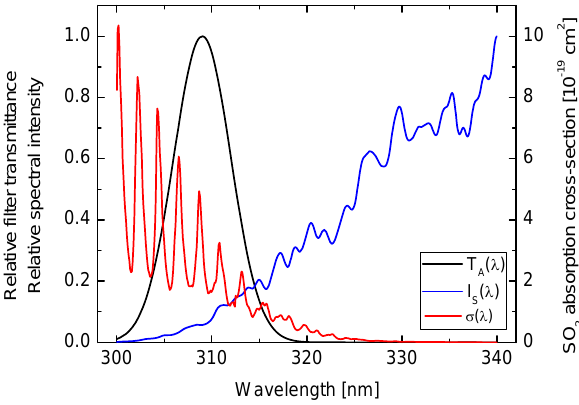
Fig. 1. Example of the spectral transmittance T ( λ ) of a band-pass filter which could be used in a SO 2 camera setup. In this case, the maximum transmittance is centered at 309nm, a region in which the SO 2 absorption-cross-section σ ( λ ) is prominent (Bogumil et al., 2003). Also shown in blue is an example spectrum of incident scattered solar radiation I S ( λ ), in this case measured with an Ocean Optics © USB2000 spectrometer at 0.7 nm resolution.